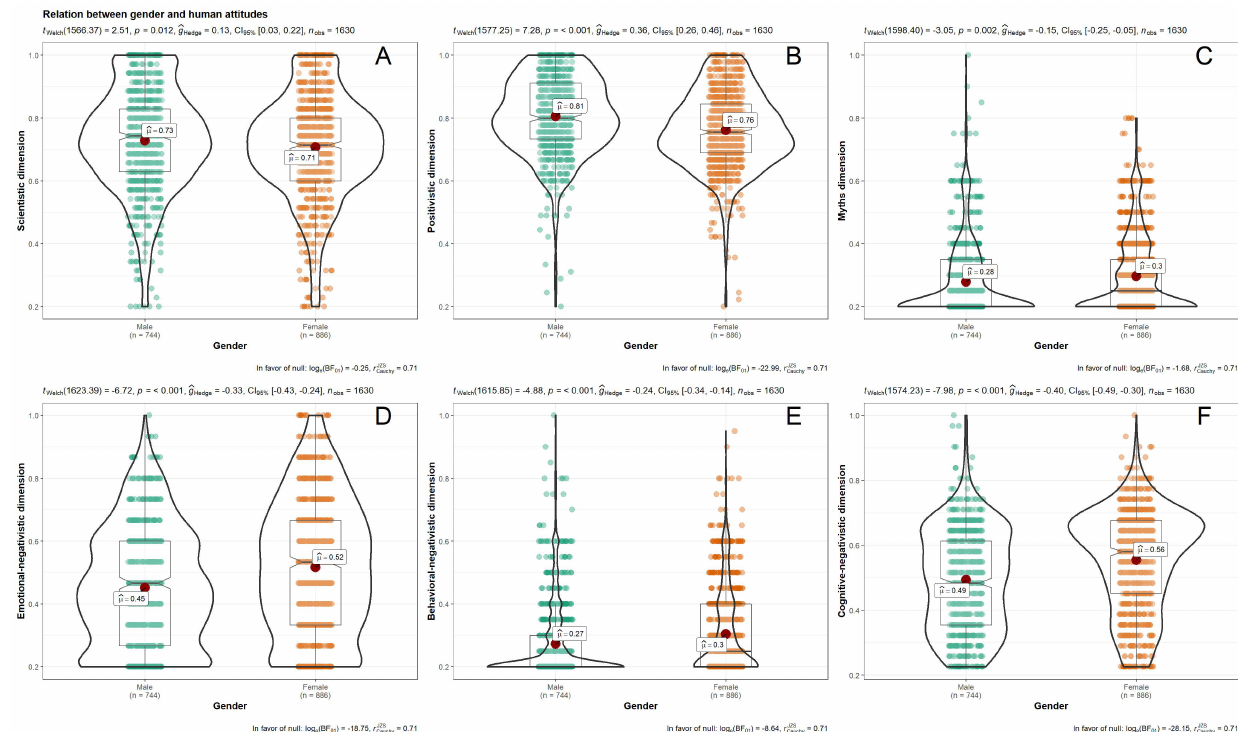
Figure 2. Difference of means between men and women in the factors of the Bats Attitudes Standard Scale (BAtSS): ( A ) = Scientific dimension; ( B ) = Positivistic dimension; ( C ) = Myths dimension; ( D ) = Emotional negativistic dimension; ( E ) = Behavioral negativistic dimension; ( F ) = Cognitive negativistic